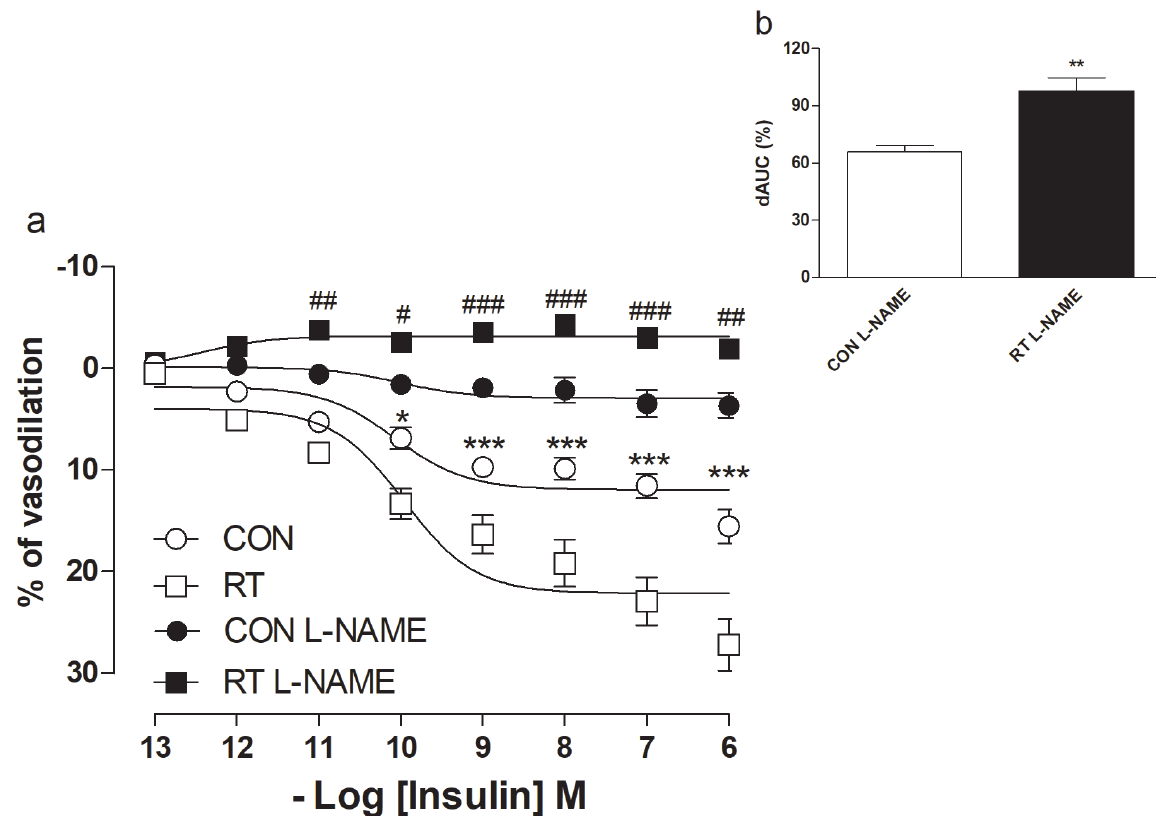
Figure 3. Concentration-response curves for insulin (10 -13 - 10 -6 M) in isolated rings of the rat superior mesenteric artery with functional endothelium and pre-contracted with Phe (1µM). (a) Rings obtained from animals of the Control group (CON) and Resistance training (RT) in the absence and presence of L-NAME (100µM). (b) Variation of the area under the curve (dAUC) between the presence and absence of L-NAME. The data represent the mean ± SEM for 8 - 10 experiments for each group. (a): * p < 0.05, *** p < 0.001, CON vs CON L-NAME. # p < 0.05, ## p < 0.01, ### p < 0.001 RT vs RT L-NAME; (b): ** p < 0.01 CON L-NAME vs. TR